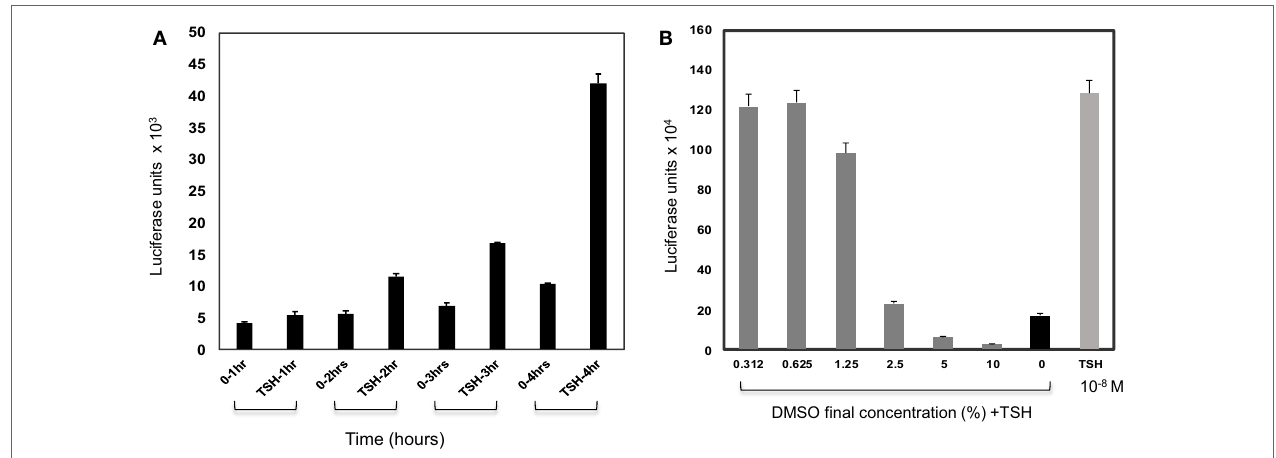
FIGURe 2 | effect of time and dMso on tshR-Glo assay. (A) Since this is a transcriptional based assay, we wanted to evaluate the effect of time. For this, the assay was performed with 10 − 9 M (100 μ U/ml) of TSH and time periods of 1, 2, 3, and 4 h without (0TSH) and with TSH treatment. Though a measurable difference in response to TSH was observed in 2 h, the response at 4 h was taken as the optimum time of incubation required for the screening because of the robust signal. (B) Since the library compounds were held in DMSO, it was imperative to test the effect of DMSO on the TSHR-Glo assay. The bars show the effect of increasing concentrations of DMSO on stimulation of the cells with TSH. We found that the bioassay could tolerate DMSO concentrations up to 1%. However, the concentration of DMSO in our actual screen was 0.1%